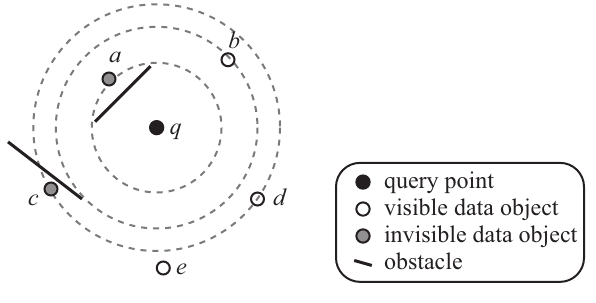
Figure 2. The V k NN